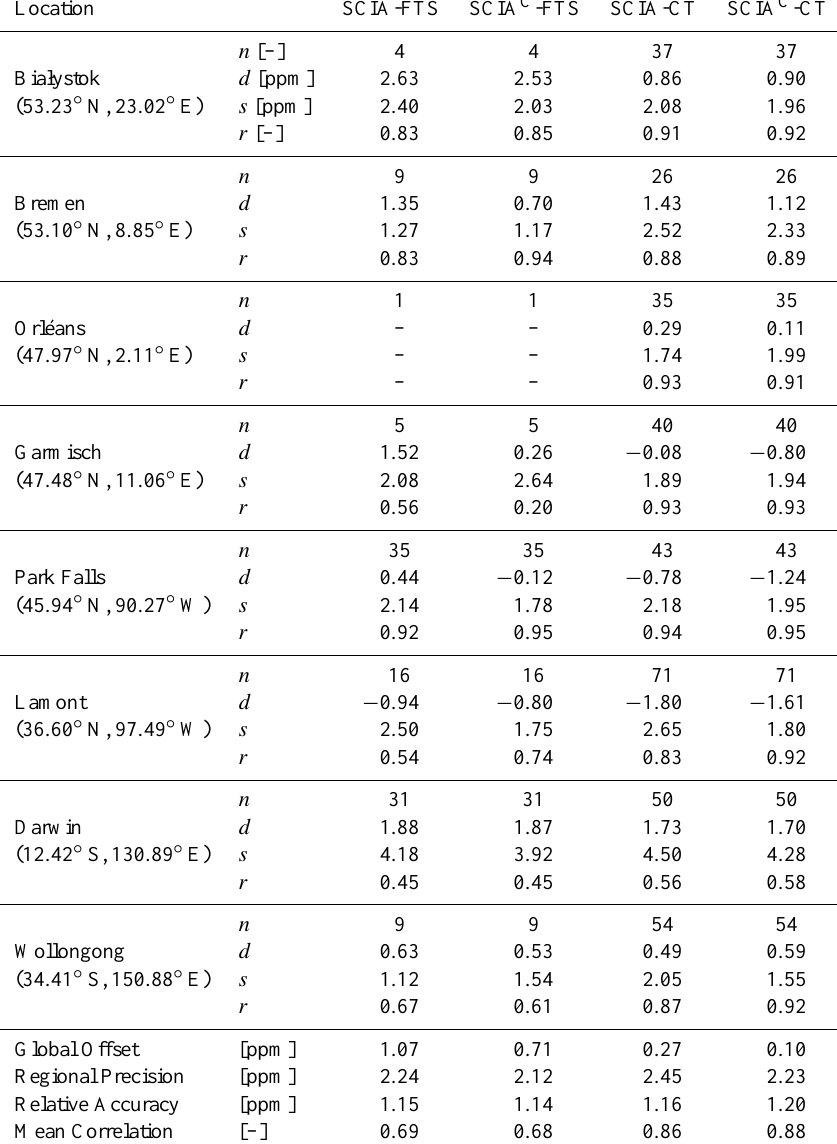
Table 1. Validation and comparison results for WFMDv2.1 XCO 2 based on monthly data within the time period 2003–2009. Shown are the number of coincident months n of data availability for SCIAMACHY and the comparative data set, the mean difference d to FTS and CarbonTracker, the standard deviation of the difference s and the correlation coefficients r for the analysed sites. Also shown are the corresponding results for the scan-angle-corrected SCIAMACHY data (SCIA C ), which form the basis of the error characterisation. The global offset is the averaged mean difference, the regional precision relative to the reference is the averaged standard deviation of the difference, and the relative accuracy is the standard deviation of the mean